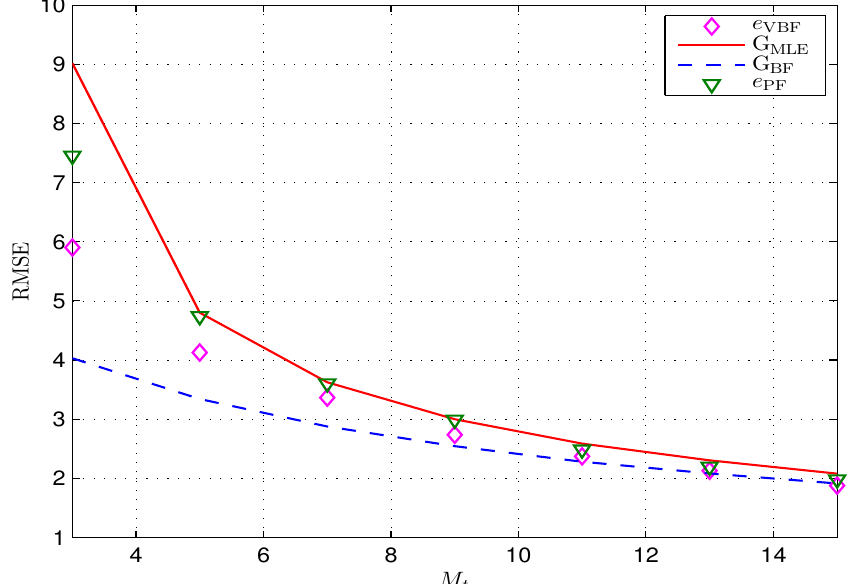
Figure 8. Achieved RMSEs with different reference cluster sizes. They y -axis is in